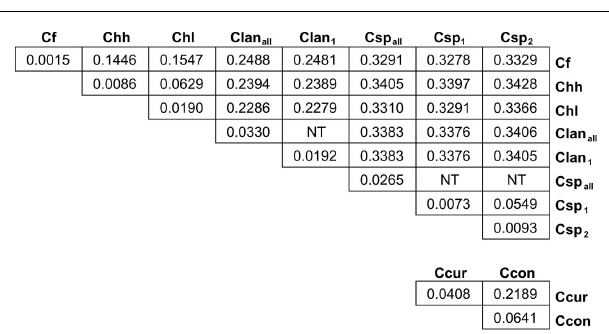
FIGURE 3 | Genetic distance between and within the Campylobacter taxa. Each value represents the average number of base substitutions per site between concatenated allele sequences. Analyses were conducted using the Kimura two-parameter model (Kimura, 1980).The analysis involved 86 nucleotide sequences. Codon positions included were first + second + third + non-coding. All positions containing gaps and missing data were eliminated.There were a total of 3312 positions in the final dataset. Evolutionary analyses were conducted in MEGA5 (Tamura et al., 2011). Branch lengths used to calculate the averages here were used to construct the dendrograms of Figures 1 and 2 . NT, not tested.The C. lanienae and C. sputorum strain sets contained divergent STs.The STs ST-1 lan and ST-4 lan were removed from the C. lanienae strain set Clan all to create Clan 1 . Similarly, ST-8 sp , ST-13 sp , ST-14 sp , and ST-15 sp were